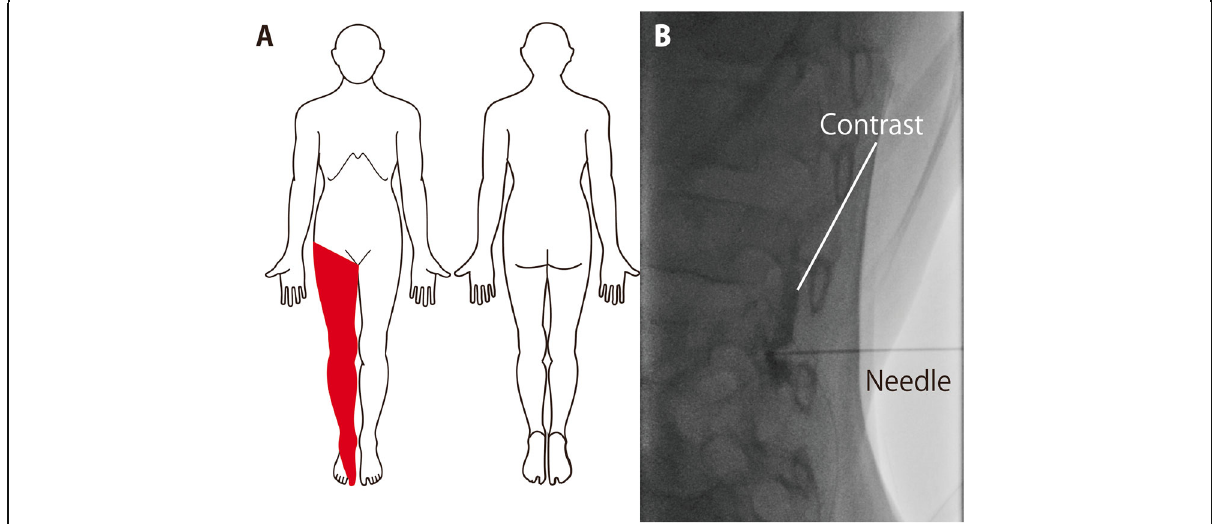
Fig. 2 Pain area ( a ), contrast imaging during the test block ( b ). The patient ’ s pain area ( a ) and contrast imaging during the test block ( b